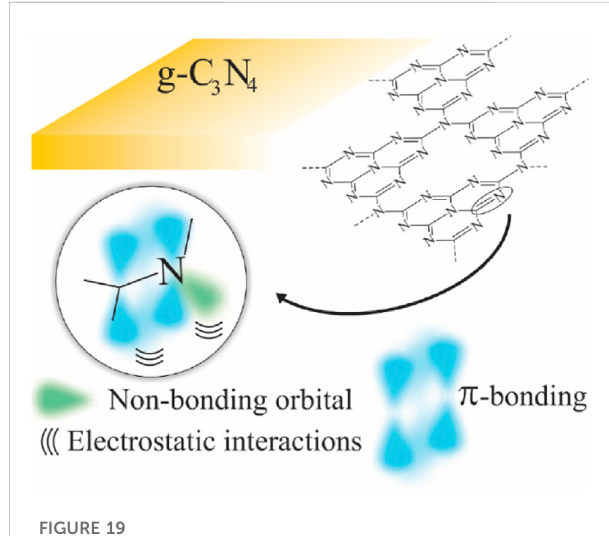
FIGURE 19 Overviewofthechemicalstructureandelectrostaticinteractions in g-C 3 N 4 (Peymanfar et al., 2022).